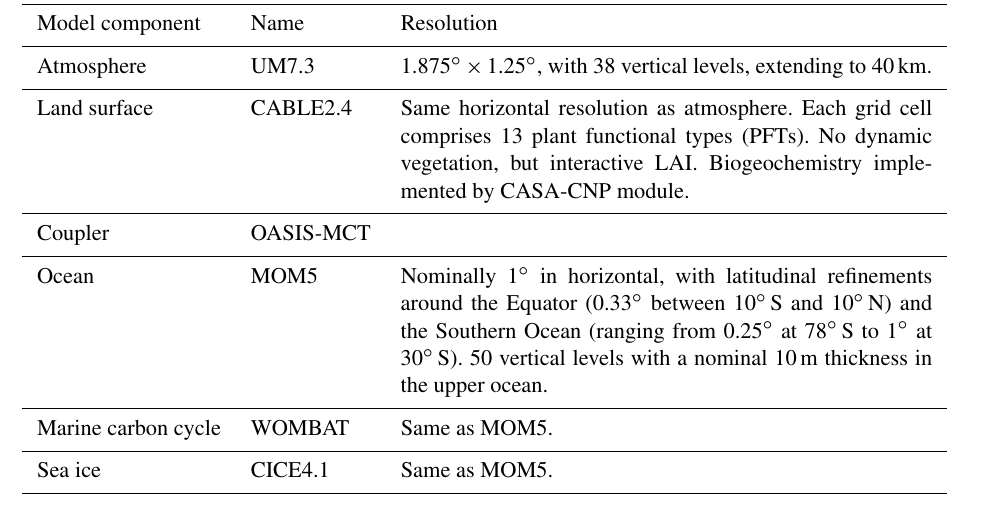
Table 2. Model components of the